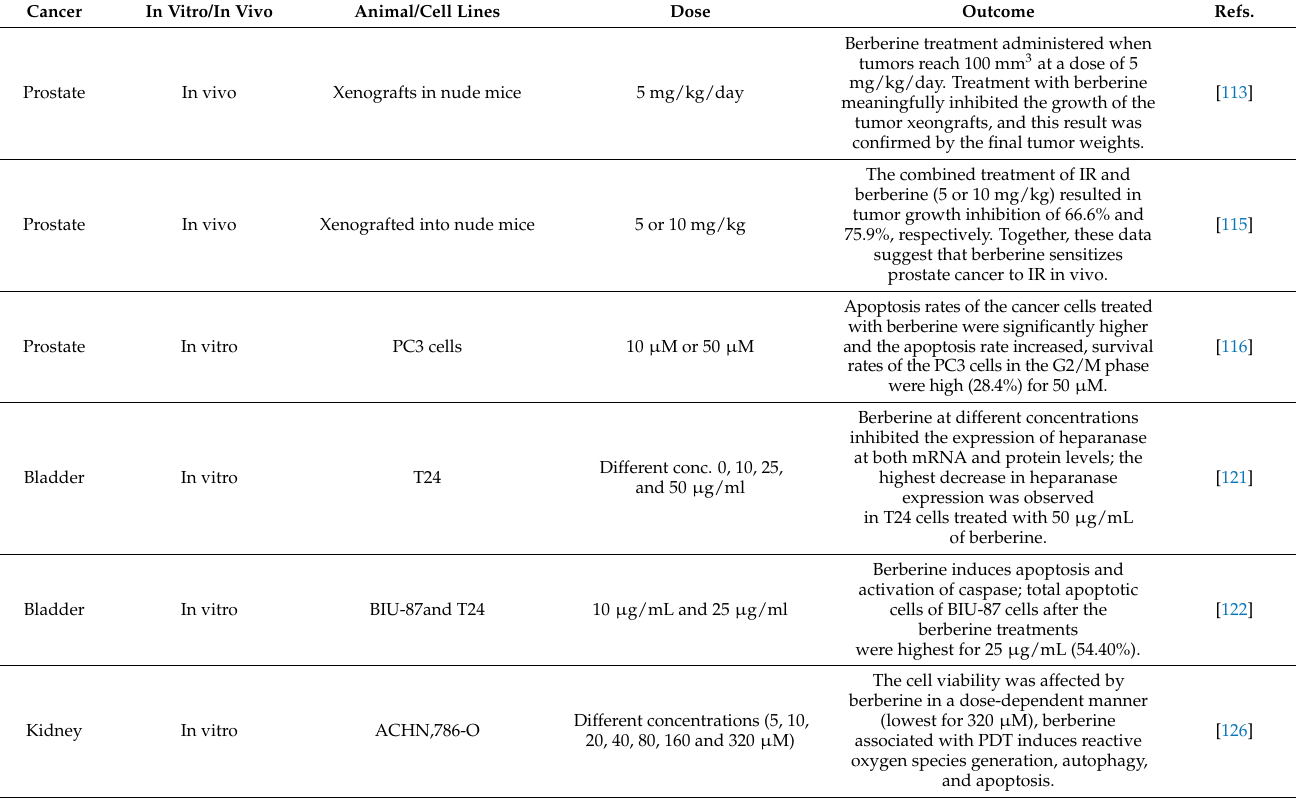
Table 2. Potential of berberine in the prevention and treatment of various types of